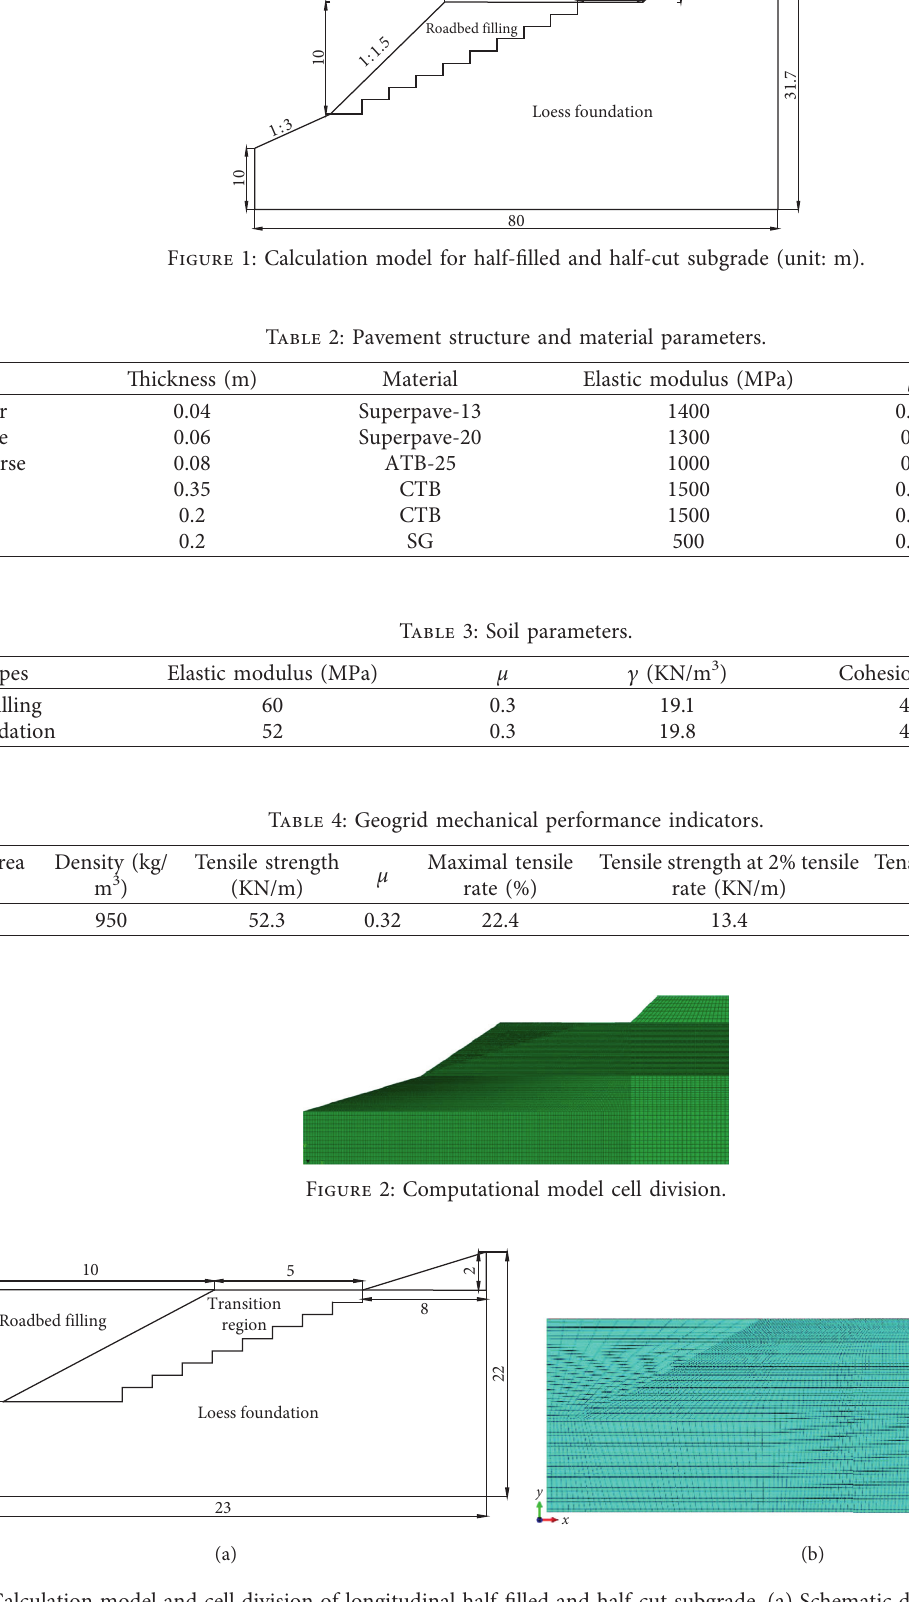
Figure 3: Calculation model and cell division of longitudinal half-filled and half-cut subgrade. (a) Schematic diagram of the calculation model (unit: m). (b) Cell division.